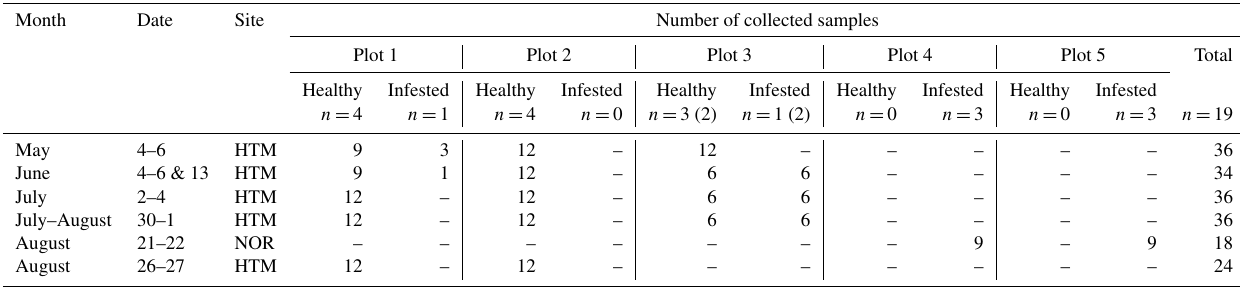
Table 1. Timetable of the sampling conducted during 2019 at the sites Hyltemossa (HTM) and Norunda (NOR). The number of trees at each plot is indicated by n and sorted in categories (healthy or infested). The samples taken from each tree during the field visits are indicated in the table, and a total of the samples are summed for each field visit and for the entire study. Note that one of the healthy spruce trees at plot 3 was infested in June and thus changed the number of healthy and infested trees at that plot (number in brackets) while the total number remained at